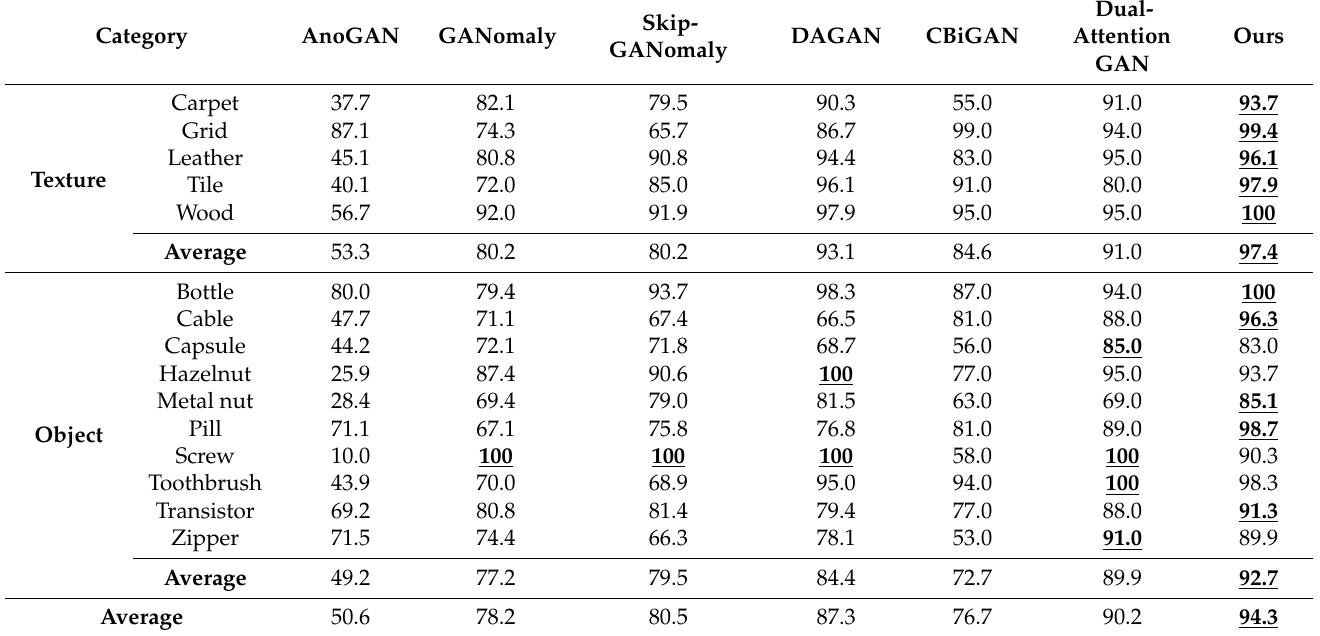
Table 2. The AUC values of the anomaly detection task in the MVTec dataset with respect to the various models we reported. The results in bold and underlined are the best AUC results.